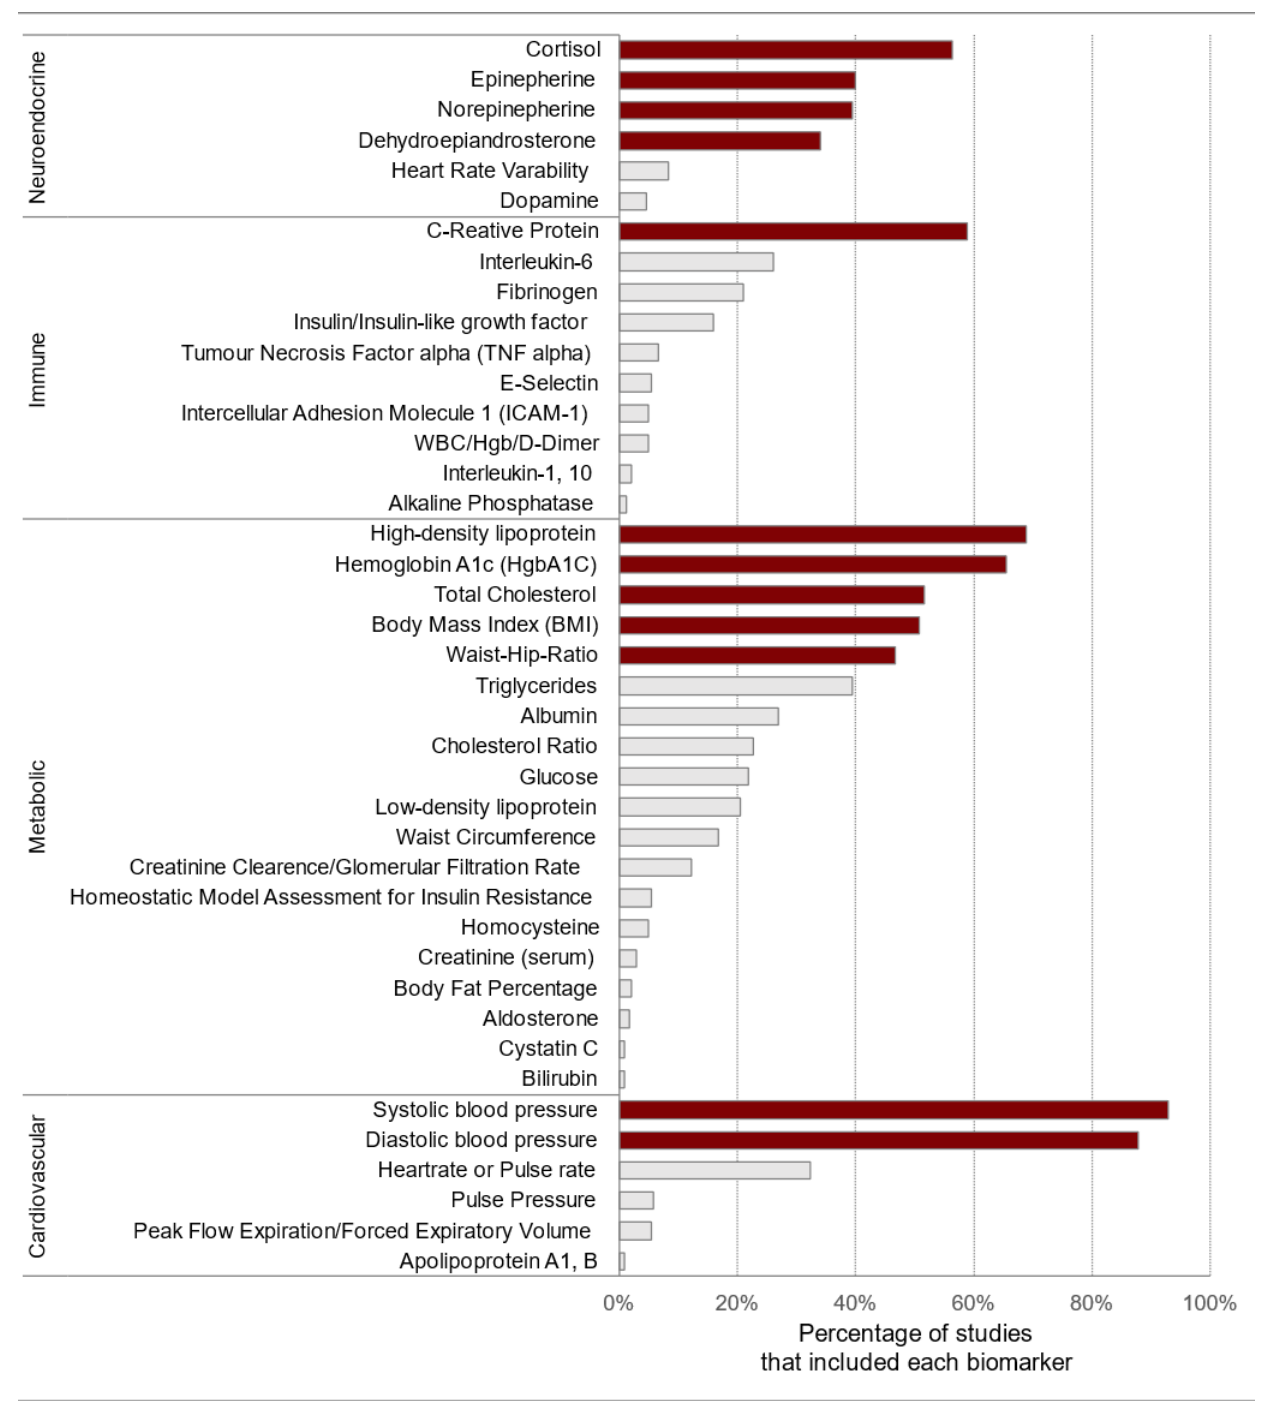
Figure 2. Biomarker use frequency extracted from 18 synthesis reviews identified through a system- atic literature search for “allostatic load” conducted on 6 July 2021. The darker shaded biomarkers are the original 10, body mass index, and C-reactive protein. Note: HgbA1C = glycosylated hemoglobin; white blood cell count (WBC), hemoglobin (Hgb).